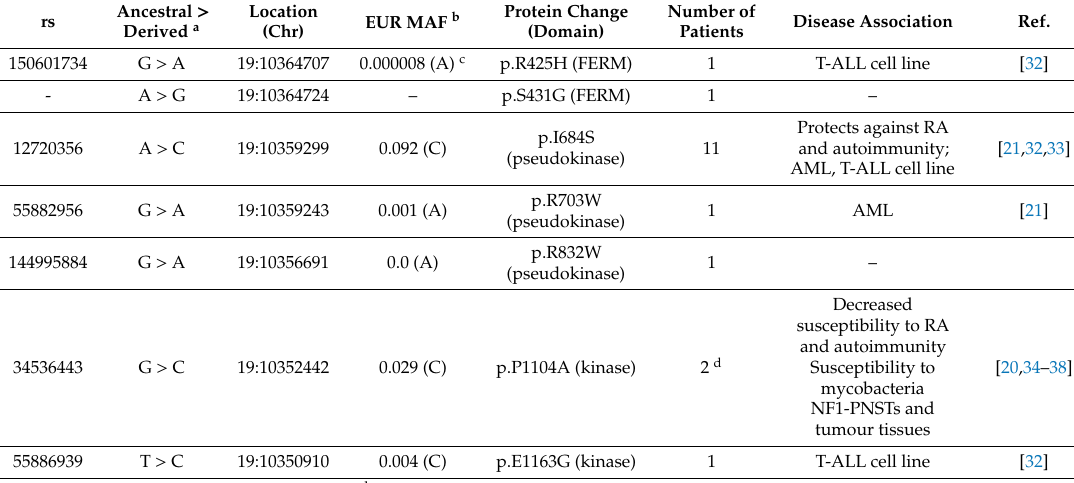
Table 1. Disease-associated non-synonymous TYK2 variants.